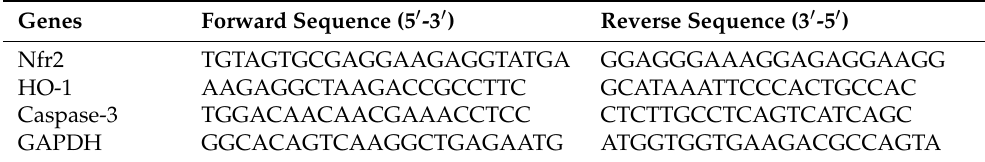
Table 2. A sequence list of the primers used for